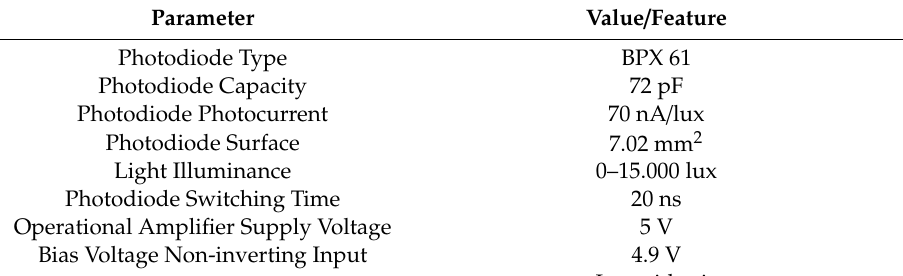
Table 2. Summary of the simulation parameters.